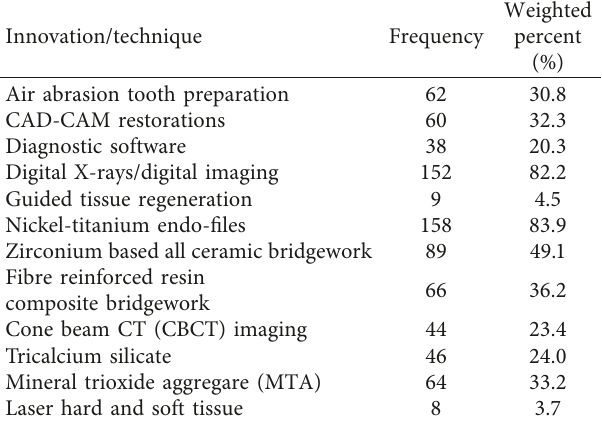
Table 4: Recent innovations and techniques.